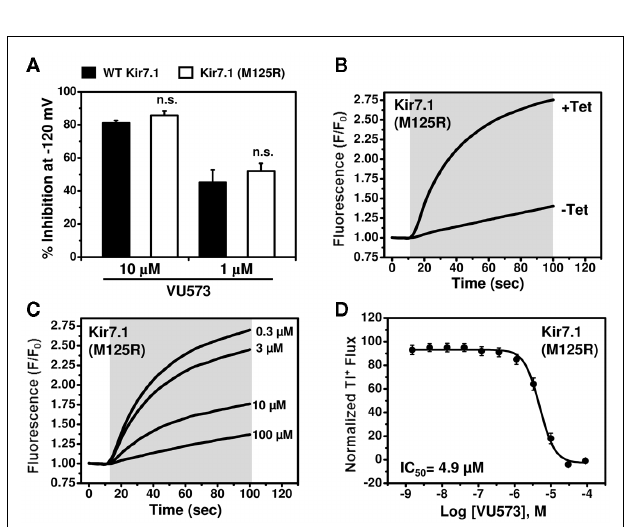
changes ofTl + -induced FluoZin-2 fluorescence following 20min pre-treatment of cells with the indicated concentrations ofVU573. (C) CRC for VU573-dependent inhibition of Kir2.3 activity.Values are mean ± SEM ( n = 3). A fit of the CRC with a single-site four-parameter logistic function yielded IC 50 of 4.7.